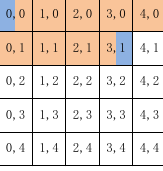
Figure 11: Initialize the State with Key, Padding and Nonce of Ketje Sr v1